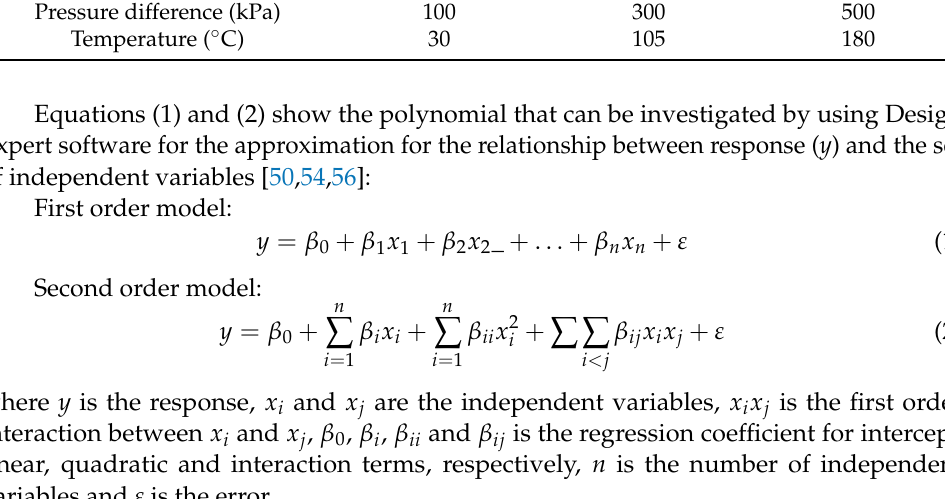
Table 1. Independent variables with ranges for CO 2 /H 2 separation studies in the current study. Level and Range Variable (Unit) − 1 0 +1 CO 2 % in the feed (%) 5.0 27.5 50.0 Pressure difference (kPa) 100 300 500 Temperature ( ◦ C) 30 105